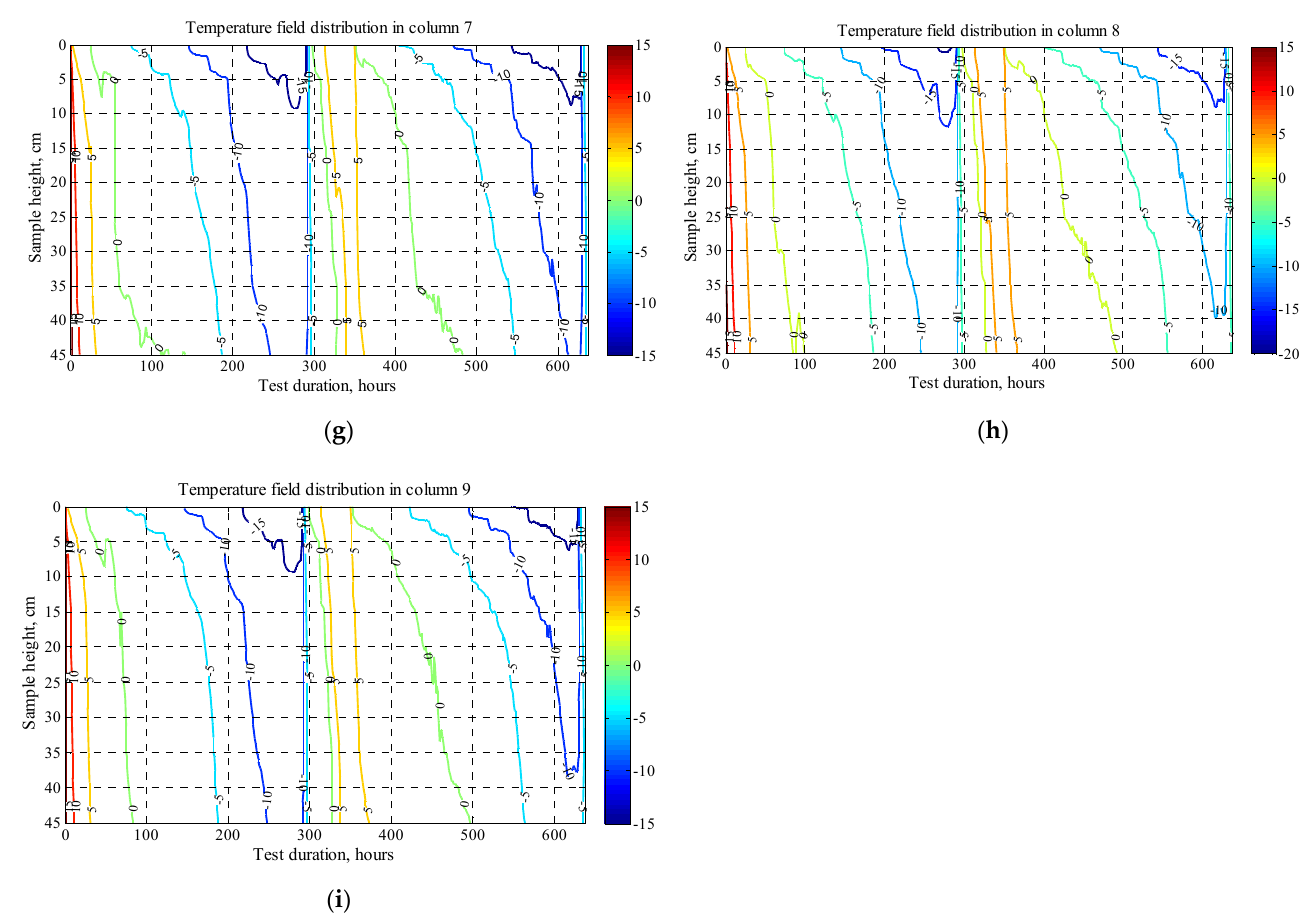
Figure 6. Temperature field distribution in columns #1–#9 within two freeze–thaw cycles: figures ( a – i ). Moisture redistribution after freeze–thaw cycles is presented in Figure 7. In the top 10 cm layer, ice lens formation caused a highly irregular distribution of moisture, which was confirmed by the centimetre-resolution sampling. Since the ground water supply table was quite shallow at 45 cm depth the moisture intake is high and this induces the capillary rise. For this reason, the moisture increase at a depth of 15 to 45 cm from the soil surface was very stable and depended just on the density of the soil samples. The frost heave that occurred in the soil samples with various densities indicates a strong connection between the packing of soil particles and the amount of frost heaving and its progress (Figure 8). The maximum rates of frost heave were achieved in columns #7 and #8, where the dry density was close to the maximum value 1650–1790 kg/m³, while the loose soil samples with dry density 1180–1470 kg/m³ registered very weak heaving in the first cycle and consolidation or compression in the second cycle compared with the initial volume.